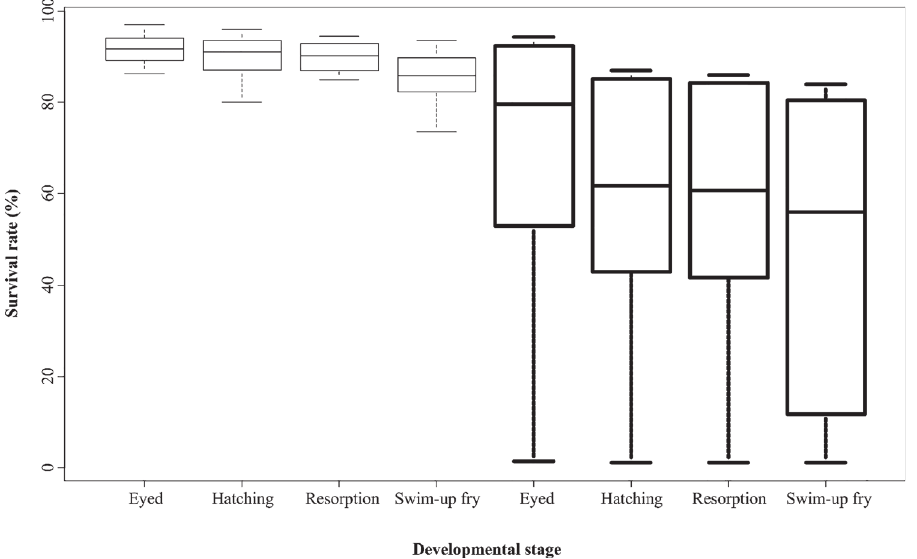
Fig 1. Individual variability of progeny survival rates at different stages from females fed the C and the V diet (in bold).